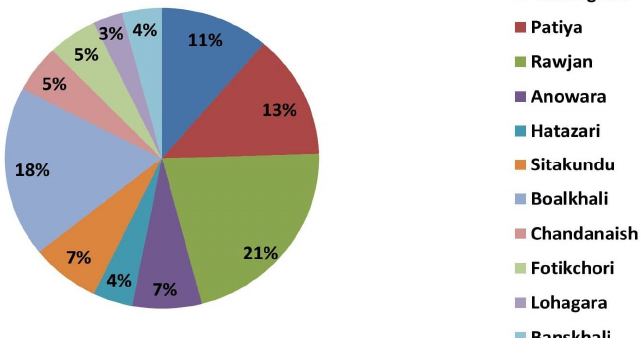
Fig. 2. Percentage of birds came from different study region of Chattogram district